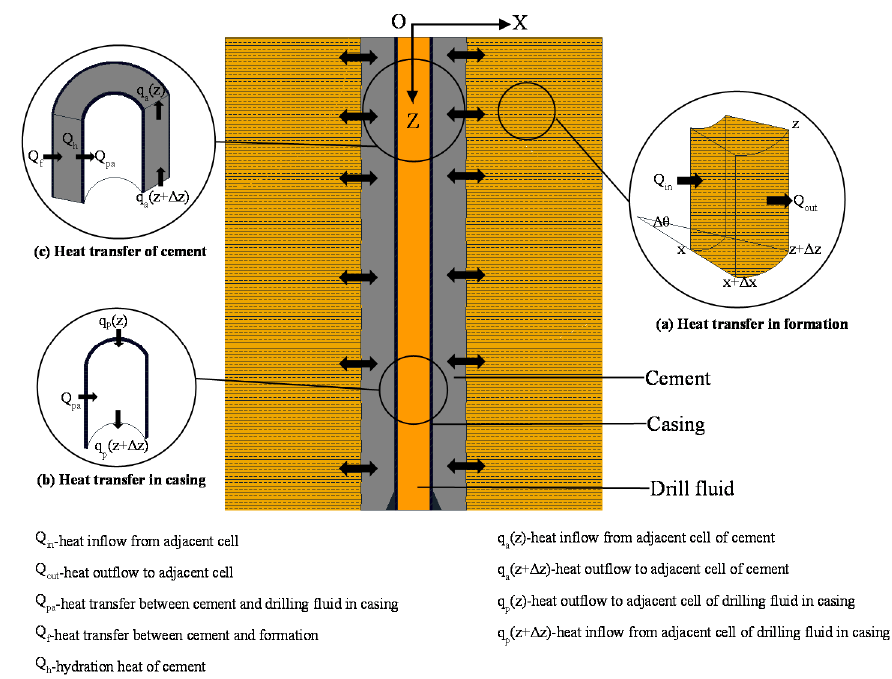
Figure 1. Heat transfer in wellbore during well cementing.